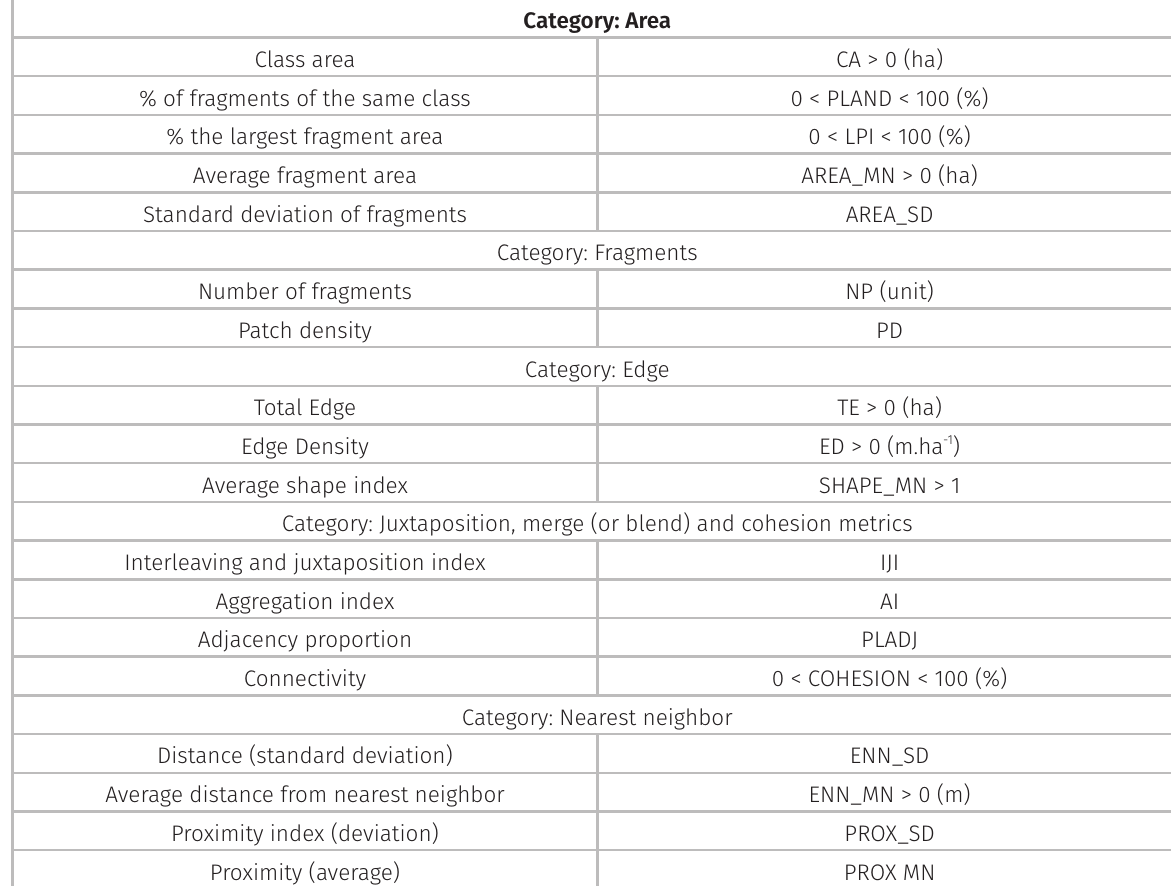
Table I. Metrics used to quantify the landscape structure of the case